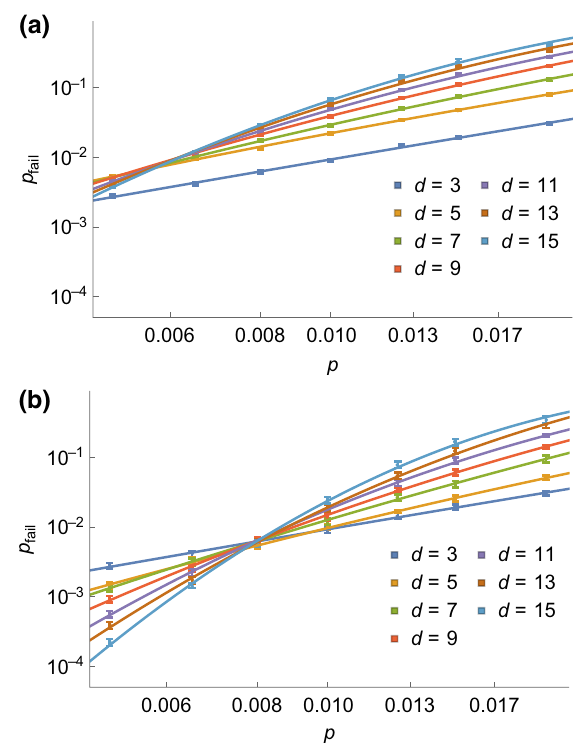
FIG. 28. Performance of the restriction decoder for the 3D color code adapted to the tetrahedral lattice L 3D with IID Z noise. Using the decoder (a) once for color Y , and (b) once each for R , G , B , and Y and then selecting the lowest weight output. This improves the performance and raises the observed threshold from 0.55 ( 5 ) % to 0.80 ( 5 )